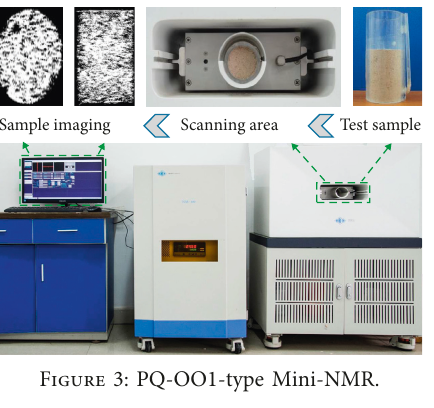
Figure 3: PQ-OO1-type